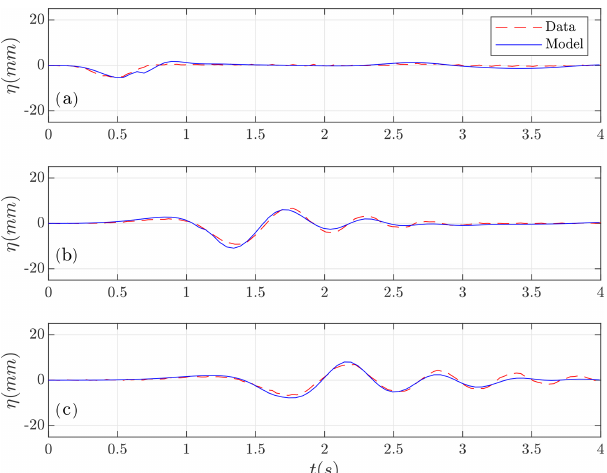
Figure 8. Test case d = 120mm. Numerically computed (in blue) time series at wave gauges (a) g 1 , (b) g 2 , and (c) g 4 compared with the lab-measured data (in